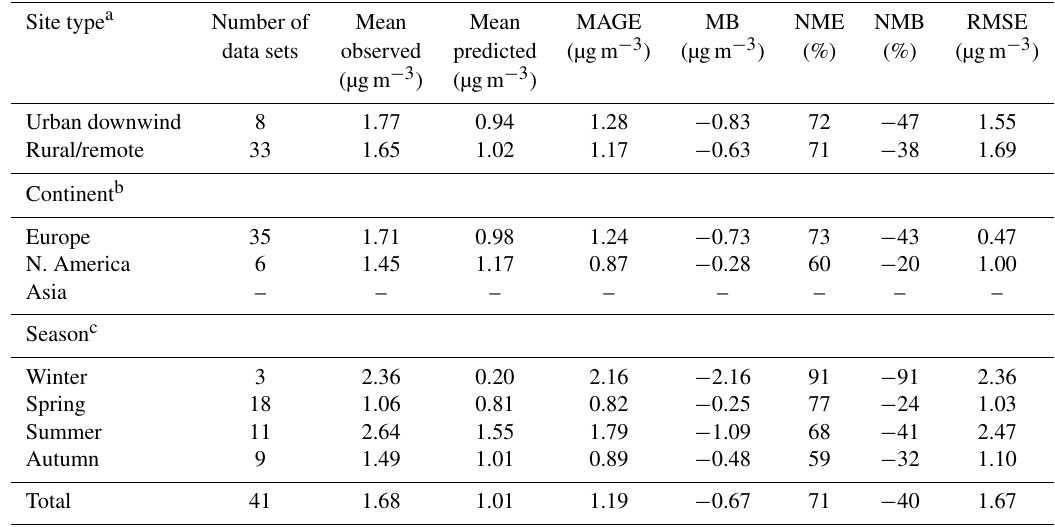
Table 5. Statistical evaluation of EMAC aged SOA against AMS LV-OOA in the Northern Hemisphere during 2001–2010. Site type a Number of Mean Mean MAGE MB NME NMB RMSE data sets observed predicted (µgm − 3 ) (µgm − 3 ) (µgm − 3 ) (µgm − 3 ) (µgm − 3 )